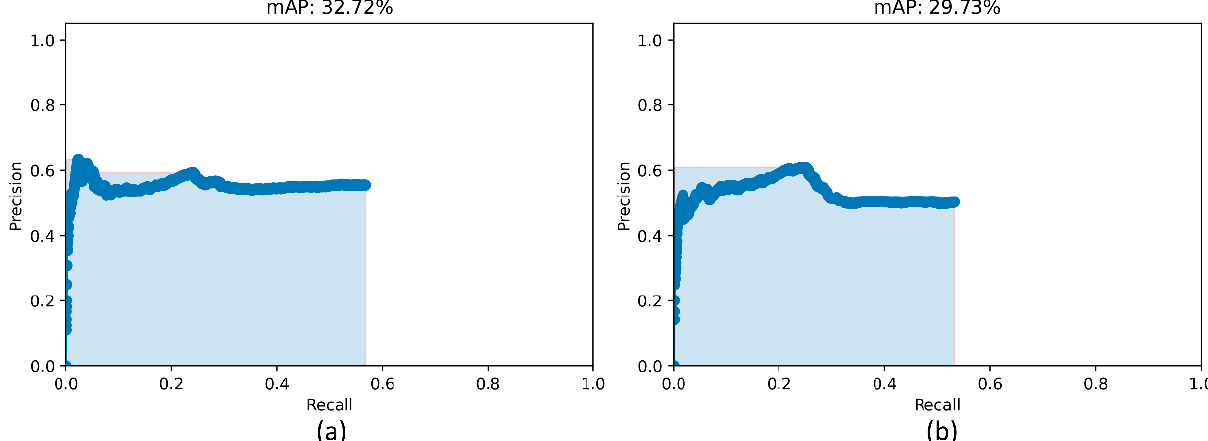
Figure 7. PR curves of the model ensembles. ( a ) PR curve obtained with the weighted-averaging ensemble of top-3 performing models (ResNet-50 with CXR modality-specific weights + focal loss, ResNet-50 with CXR modality-specific weights + focal Tversky loss, and ResNet-50 with random weights + focal loss and ( b ) PR curve obtained with the ensemble of top-3 performing snapshots while training the ResNet-50 with CXR modality-specific weights + focal loss model.